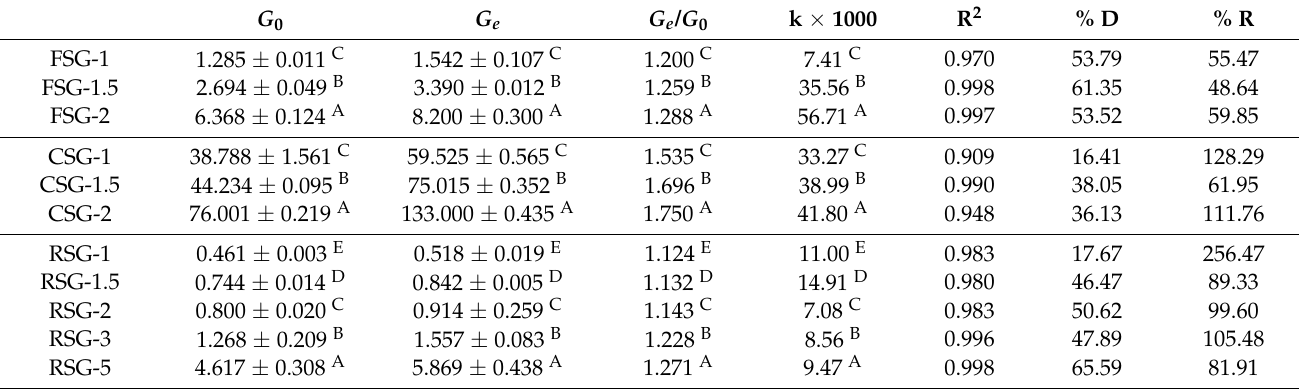
Table 4. Second-order structural kinetic model parameters for 3-ITT.